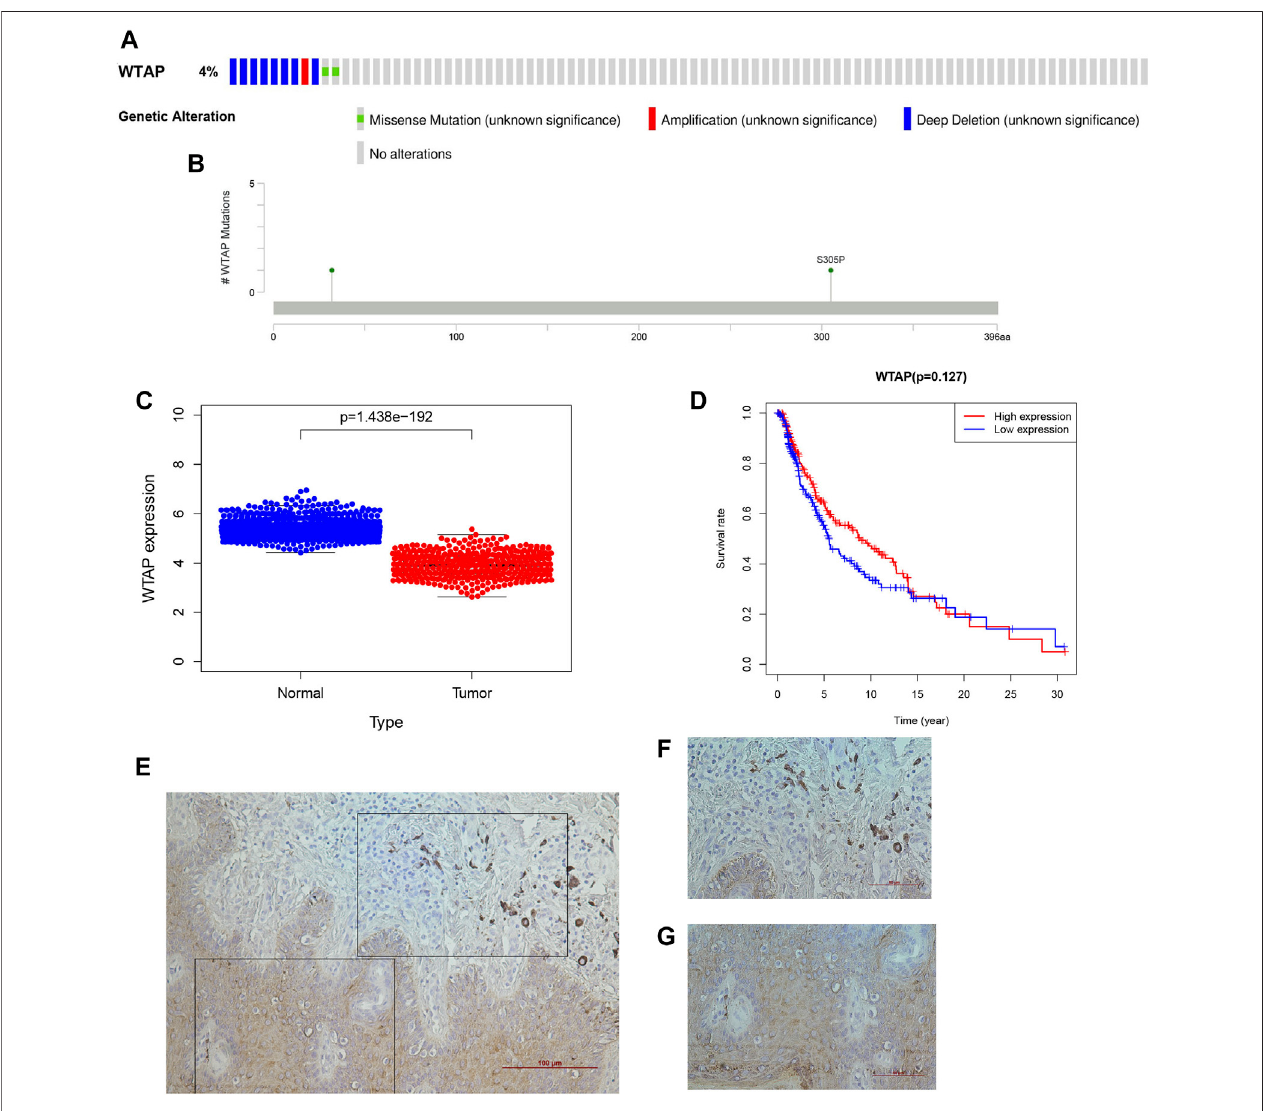
FIGURE 8 | WTAP as a novel prognostic biomarker in cutaneous melanoma. (A) OncoPrint of WTAP altertions in melanoma cohort identi fi ed by cBioPortal. (B) lollipop of WTAP alteration in melanoma cohort identi fi ed. (C) The differential expression of WTAP in cutaneous melanoma. (D) The overall survival of cutaneous melanoma patients in the two clusters (high WTAP expression group and the low WTAP expreaaion group) was calculated by Kaplan-Meier curves. (E-G) The histological features of WTAP gene in cutaneous melanoma (F) and their adjacent tissuses (G) .